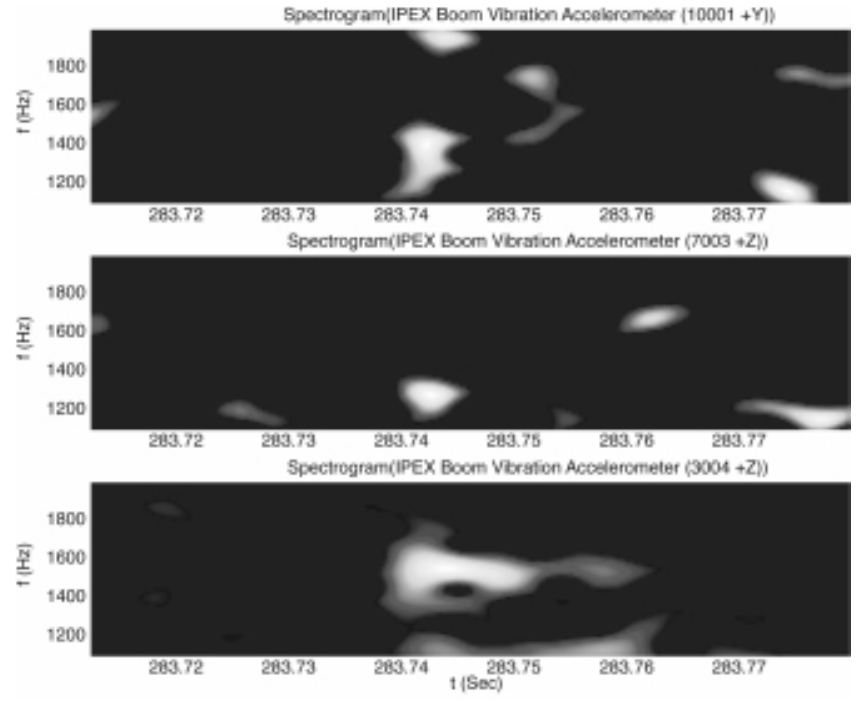
Fig. A12. Event 4 Nodes 3004, 7003 & 10001